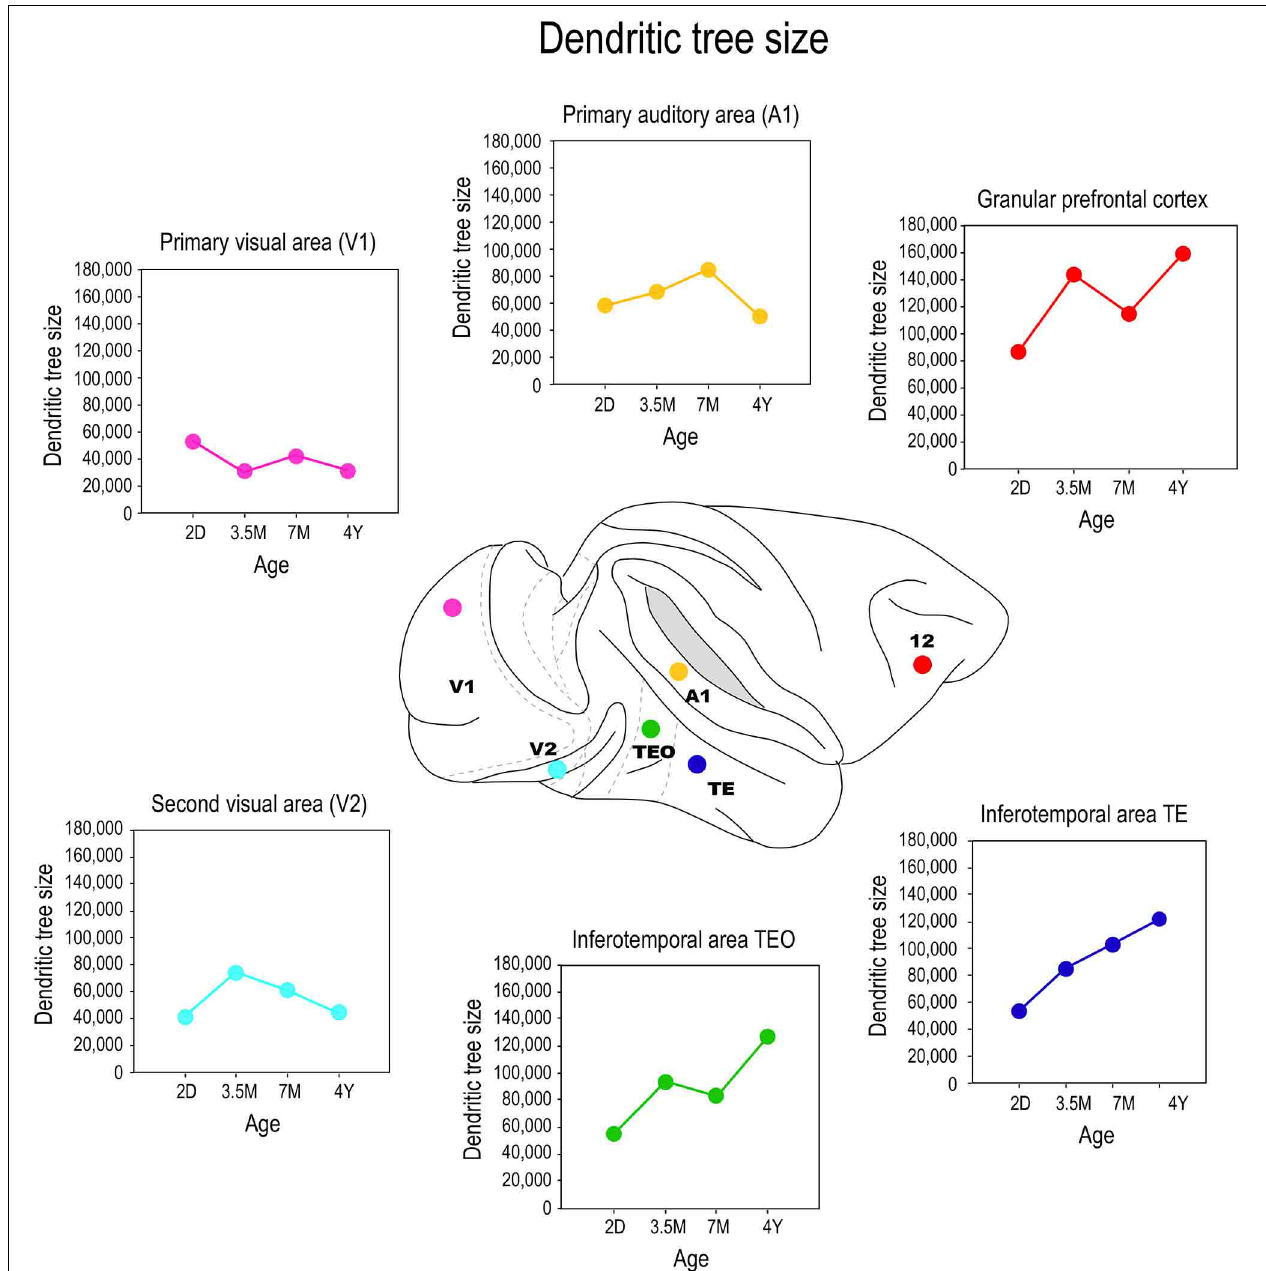
FIGURE 5 | Growth profiles. Plots of the size of the basal dendritic trees of layer III pyramidal neurons sampled from primary visual area (V1), the second visual area (V2), the primary auditory cortex (A1), the posterior and anterior portion of the inferotemporal cortex (TEO and TEpd, reported in human: cells become smaller after birth (Becker et